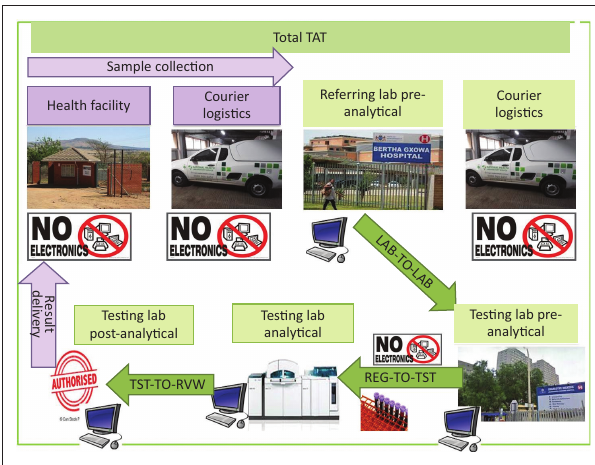
FIGURE 1: A logical flow of samples from the referring to the testing laboratory, indicating the individual components of total laboratory turn-around time (green). This consists of LAB-TO-LAB (time from registration at referral laboratory to registration at testing laboratory); REG-TO-TST (time to capture CD4 result from registration at testing laboratory) and TST-TO-RVW (time from CD4 result to authorisation on LIMS). Purple elements represent sample collection at the health facility and transport to the referring laboratory, as well as result delivery back to the health facility, which are not included in the laboratory turn-around time